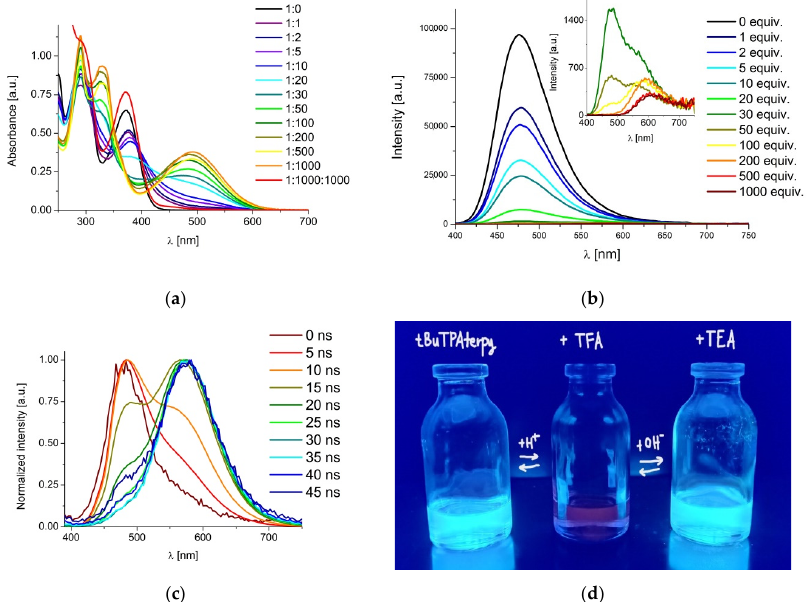
Figure 6. ( a ) UV–Vis titration experiment of tBuTPAterpy (c = 1 × 10 − 5 M) with TFA (1–1000 equivalents) in CHCl 3 (red line represents spectra for 1 tBuTPAterpy : 1000 TFA: 1000 TEA); ( b ) PL spectral changes after titration of a tBuTPAterpy (c = 1 × 10 − 5 M) chloroform solution with TFA (1–1000 equivalents); inset: PL spectra for TFA additions in the range 30–1000 equivalents; ( c ) Normalized TRES of tBuTPAterpy (c = 1 × 10 − 5 M) with 50 equivalents of TFA ( λ PE = 375 nm; emission slit: 10 nm; detector signal: 6000 cps, wavelength step: 3 nm, stop conditions: 300 s); ( d ) Picture showing PL changes after sequential additions of TFA (1000 equivalents) and TEA (1000 equivalents) to a chloroform solution of tBuTPAterpy